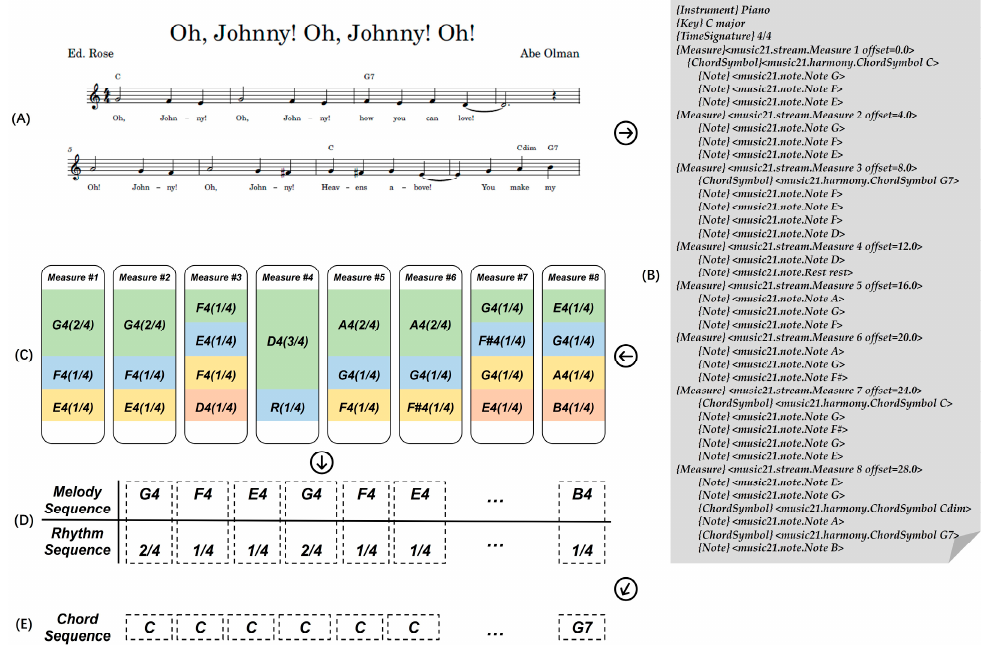
Figure 1. Pipeline of token representation. ( A ) A example leadsheet in music corpus; ( B ) The events converted from MusicXML; ( C ) Extracted events related to the melody, rhythm and chords; ( D ) Generated melody sequence and rhythm sequence; ( E ) Generated chord sequence.